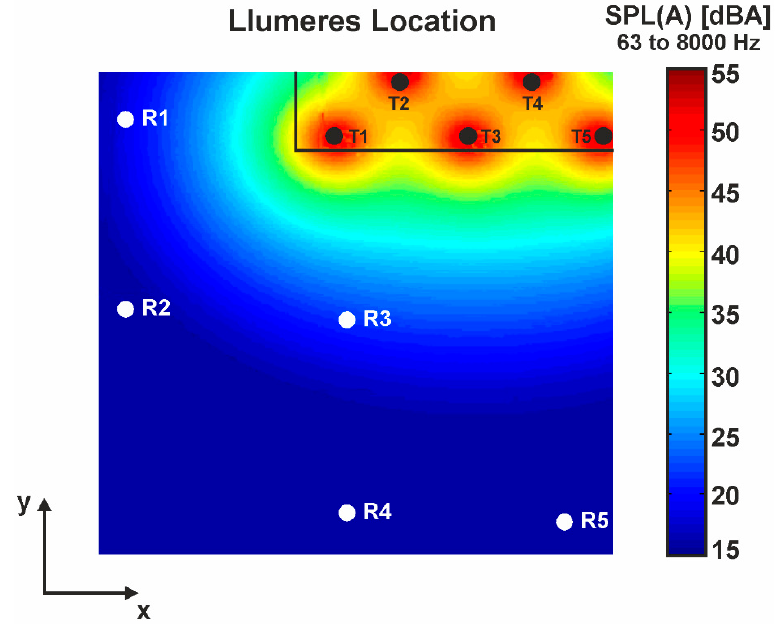
Figure 8. Noise map (dBA) in the Llumeres scenario. Table 4. Octave-band sound pressure levels for each receiver at the Cape Busto